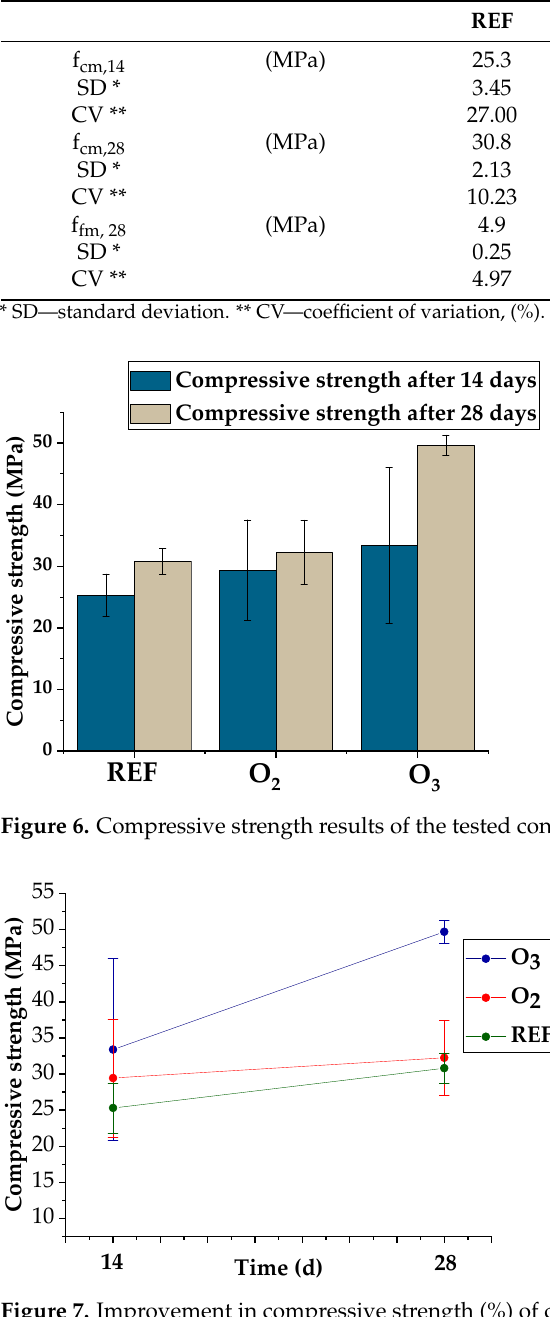
Figure 7. Improvement in compressive strength (%) of concrete.